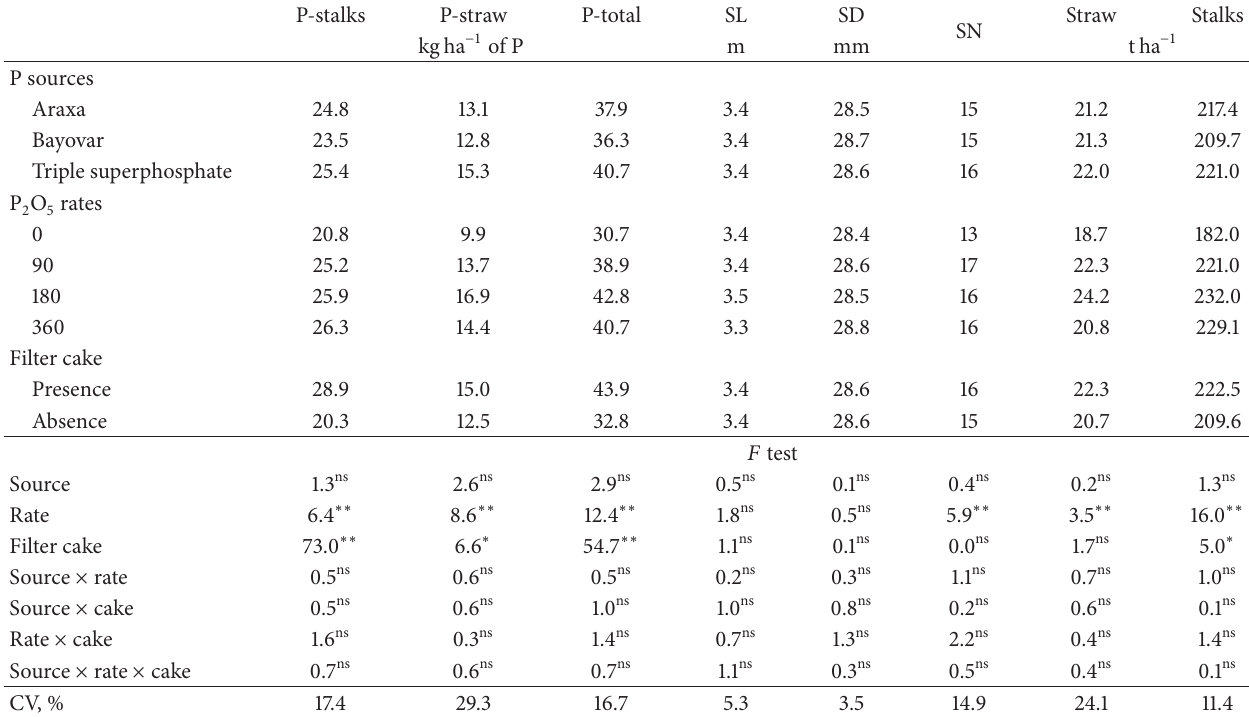
Table 2: Stalk phosphorus accumulation (P-stalk) in leaves and apical meristem (P-straw), total (P-total), length (SL), diameter (SD), stalk number (SN), and the productivity of straw and stalks of sugarcane grown in Eutrophic Red Ultisol, as a function of phosphate fertilizer with different P sources, P application rates, and filter cake. P-stalks P-straw P-total SL SD Straw Stalks SN kg ha −1 of P mm tha